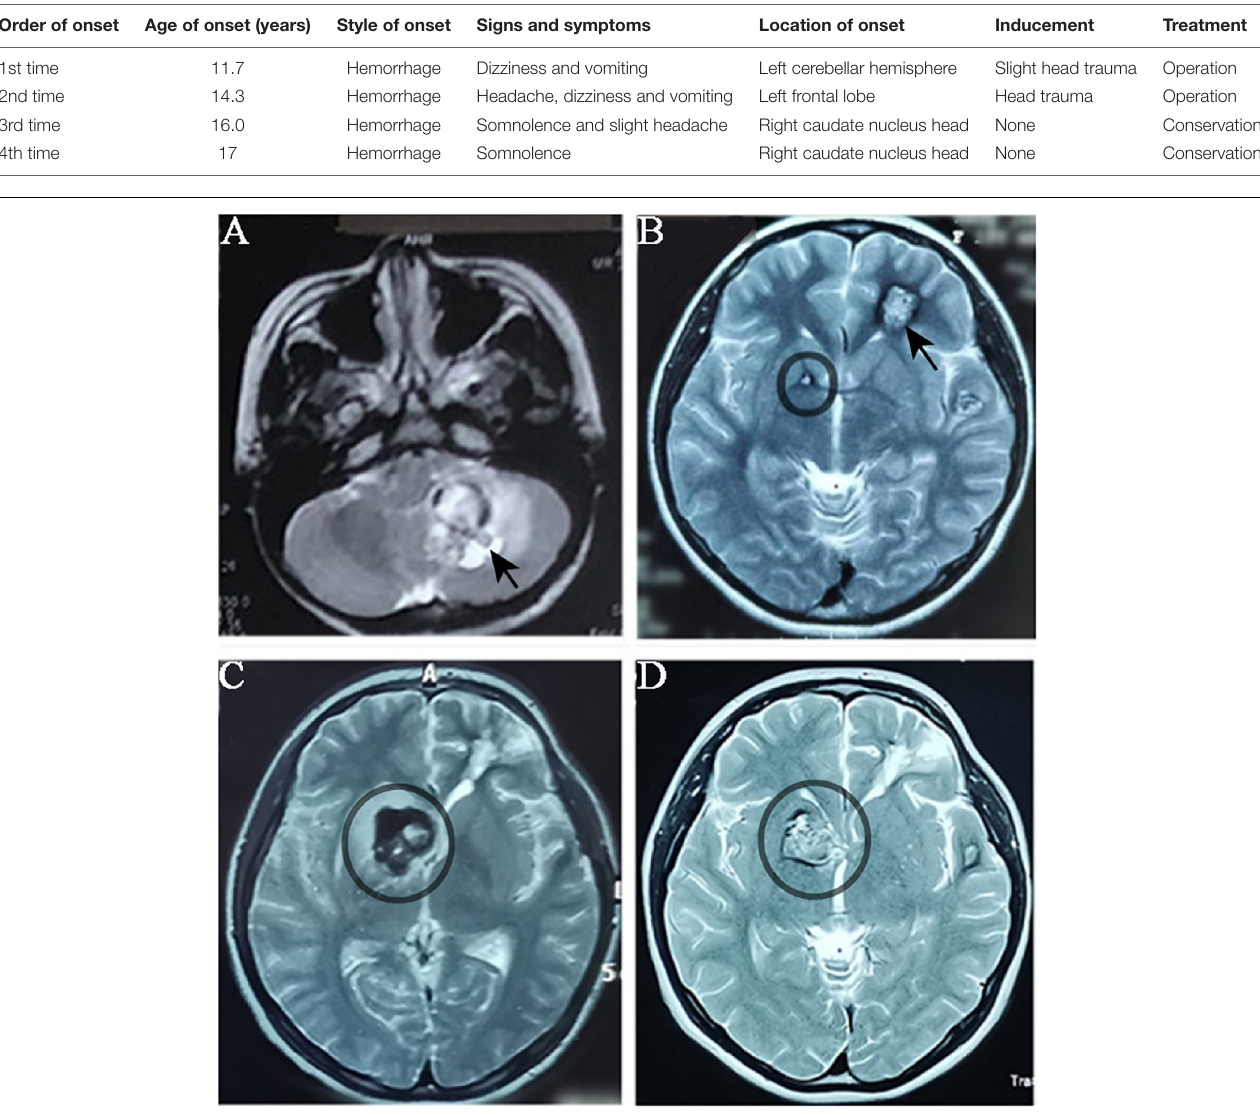
DNA was extracted using PureLink Genomic DNA Mini Kit (Invitrogen, United States). DNA quality was examined using the 2100 Bioanalyzer System. Genomic DNA was sheared into 150–200 bp using the Bioruptor Pico (Bioruptor, United